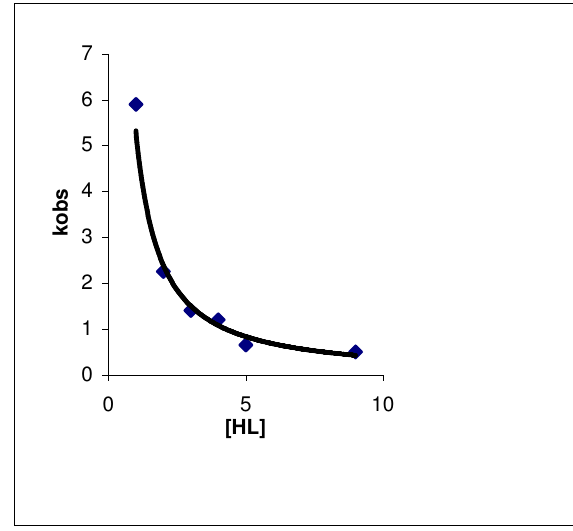
Figure 1. Plot of kobs vs added